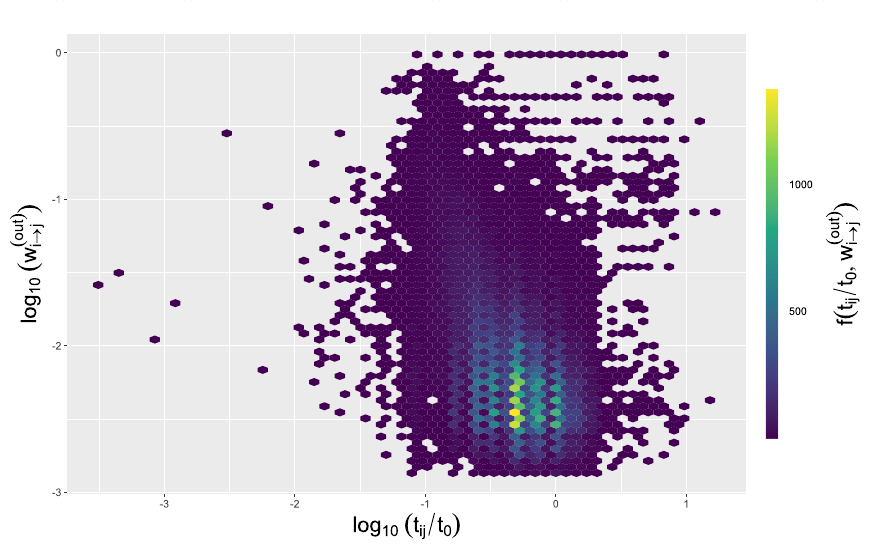
( out ) ) ) for all trip types in the Madrid log 10 ( t ij i → j , t 0